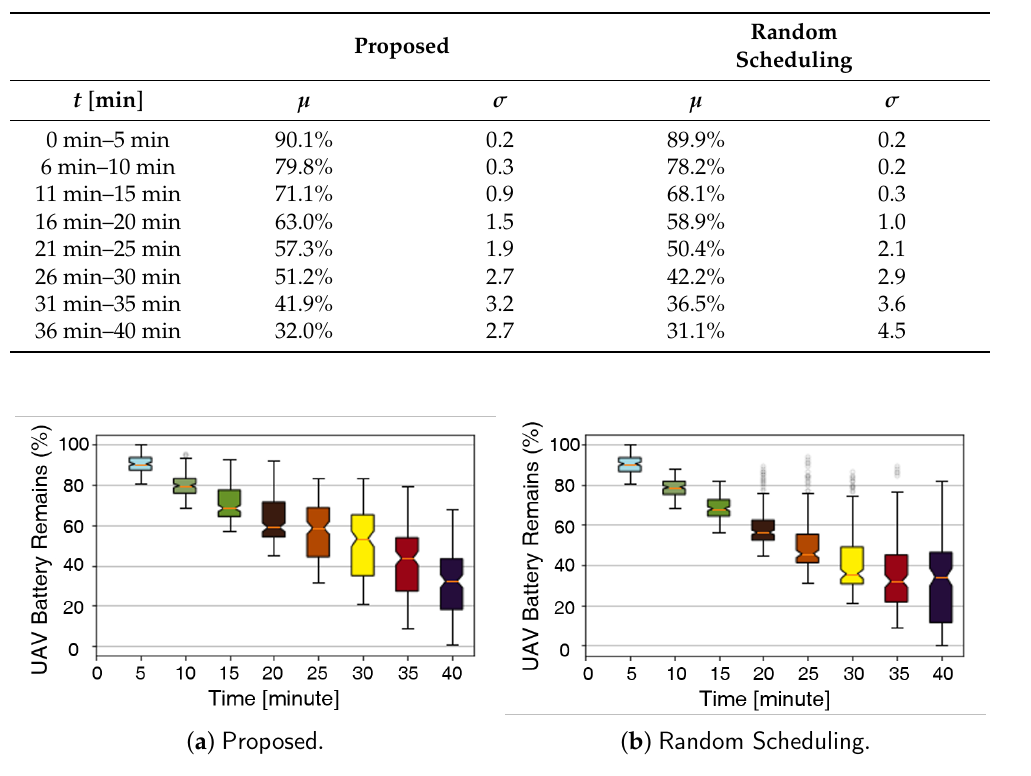
Figure 3. UAV residual battery/energy distribution comparison between ( a ) the Proposed algorithm and ( b ) Random Scheduling